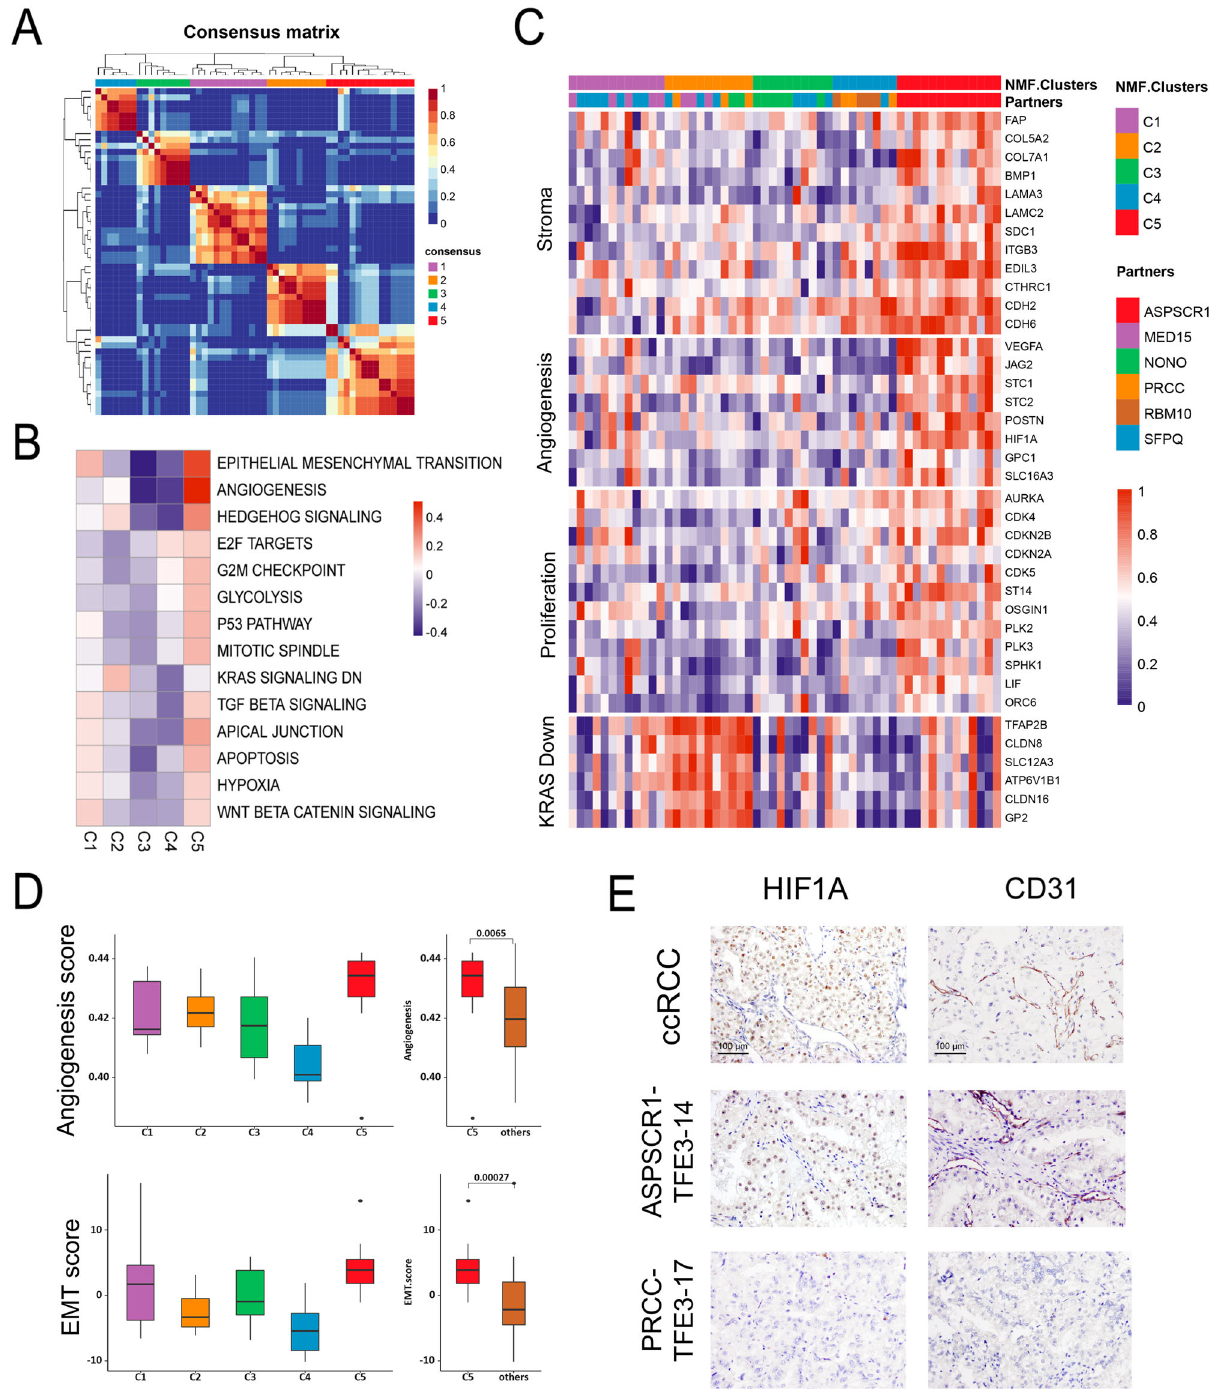
Fig. 5 Transcriptional strati fi cation identi fi es TFE3-tRCC tumor subsets with distinct biologic features. A Consensus matrix depicting clusters ( k = 5) identi fi ed by NMF clustering of tumors with de fi nite fusion partners ( n = 54). B Heatmap representing MSigDb hallmark gene set QuSAGE enrichment scores for each NMF tumor cluster compared with all other tumors. White cells represent non-signi fi cant enrichment after FDR correction. C Heatmap of genes comprised in transcriptional signatures. Samples are grouped by NMF cluster. D Comparative angiogenesis score (top) and EMT score (bottom) in samples between the different NMF tumor clusters (C1 – C5). C1, n = 12; C2, n = 11; C3, n = 10; C4, n = 8; C5, n = 13; others = C1 + C2 + C3 + C4, n = 41. Box plots show median levels (middle line), 25th and 75th percentile (box), 1.5 times the interquartile range (whiskers) as well as outliers (single points). P values were determined by the two-sides Mann – Whitney U test. E Representative IHC demonstrating HIF1A and CD31 expression in two selected samples (TFE3-14 and TFE3-17) in our cohort and one positive control (ccRCC with VHL mutant). Five random high-power fi elds were checked for HIFA and CD31 positive expression. Magni fi cation × 200. Scale bar = 100 μ m. TFE3 -tRCC TFE3 -translocation renal cell carcinoma, NMF non-negative matrix factorization, EMT epithelial-mesenchymal transition, IHC